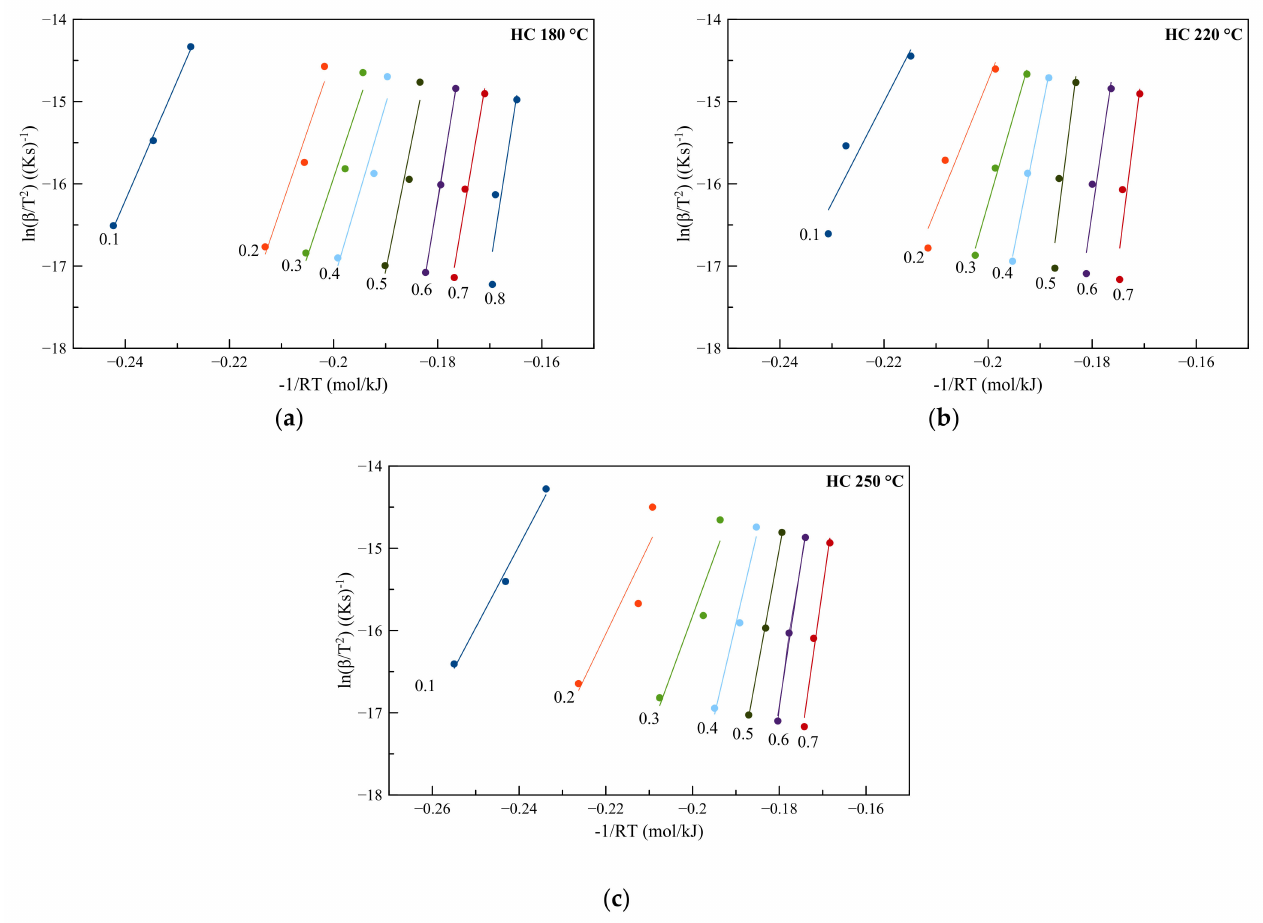
Figure 7. Miura–Maki diagrams of pyrolysis of: ( a ) hydrochar 180 ◦ C; ( b ) hydrochar 220 ◦ C; ( c ) hydrochar 250 ◦